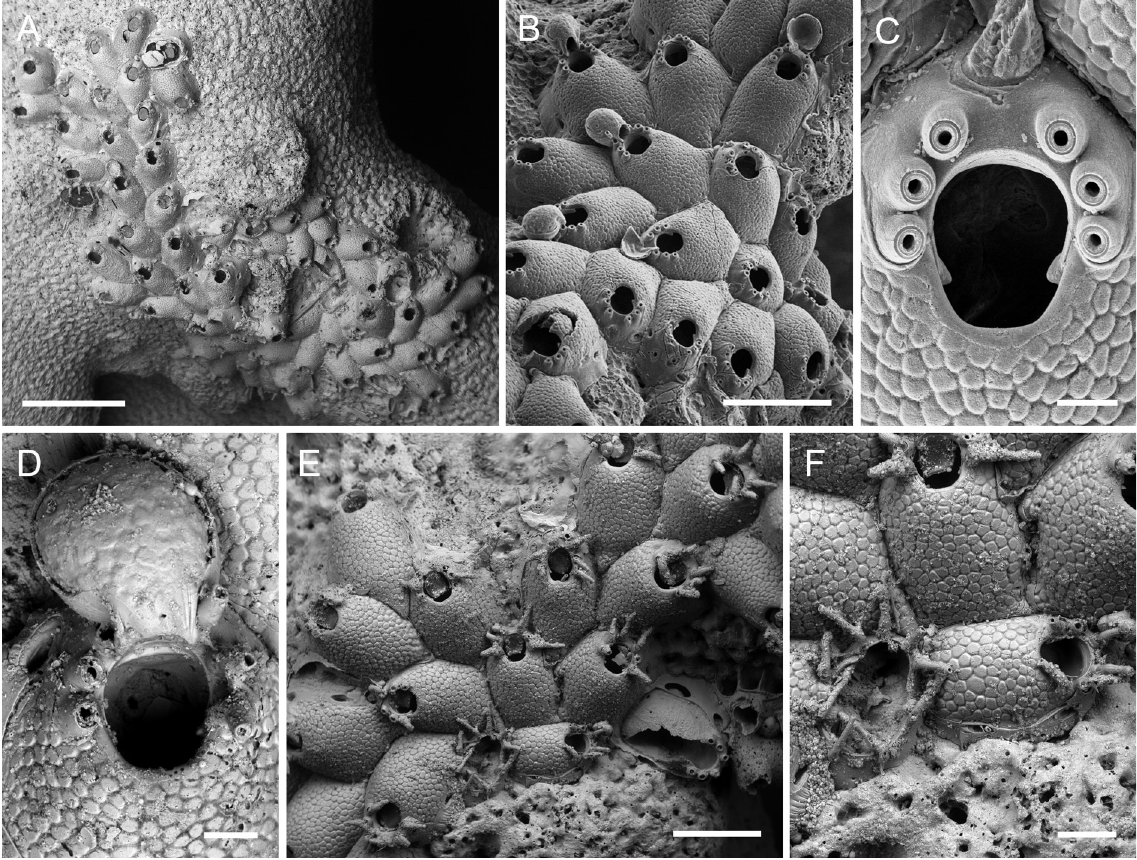
Fig. 2. Atlantisina atlantis gen. et sp. nov., Atlantis Smt. A . Overview of colony growing on a stylasterid skeleton; note the biserial-branching growth (paratype MNHN-IB-2014-47). B . Several autozooids and ovicellate zooids (paratype MNHN-IB-2014-49). C . Close-up of orifice and the base of a severed ovicell protruding from the distal communication pore (paratype MNHN-IB-2014-49). D . Ooecium (OLL 2016/127). E . Periancestrular region (paratype OLL 2016/123). F . Ancestrula and first-generation autozooid (paratype OLL 2016/123). Scale bars: A = 1 mm; B = 500 µm; C–D = 50 µm; E = 300 µm; F = 100